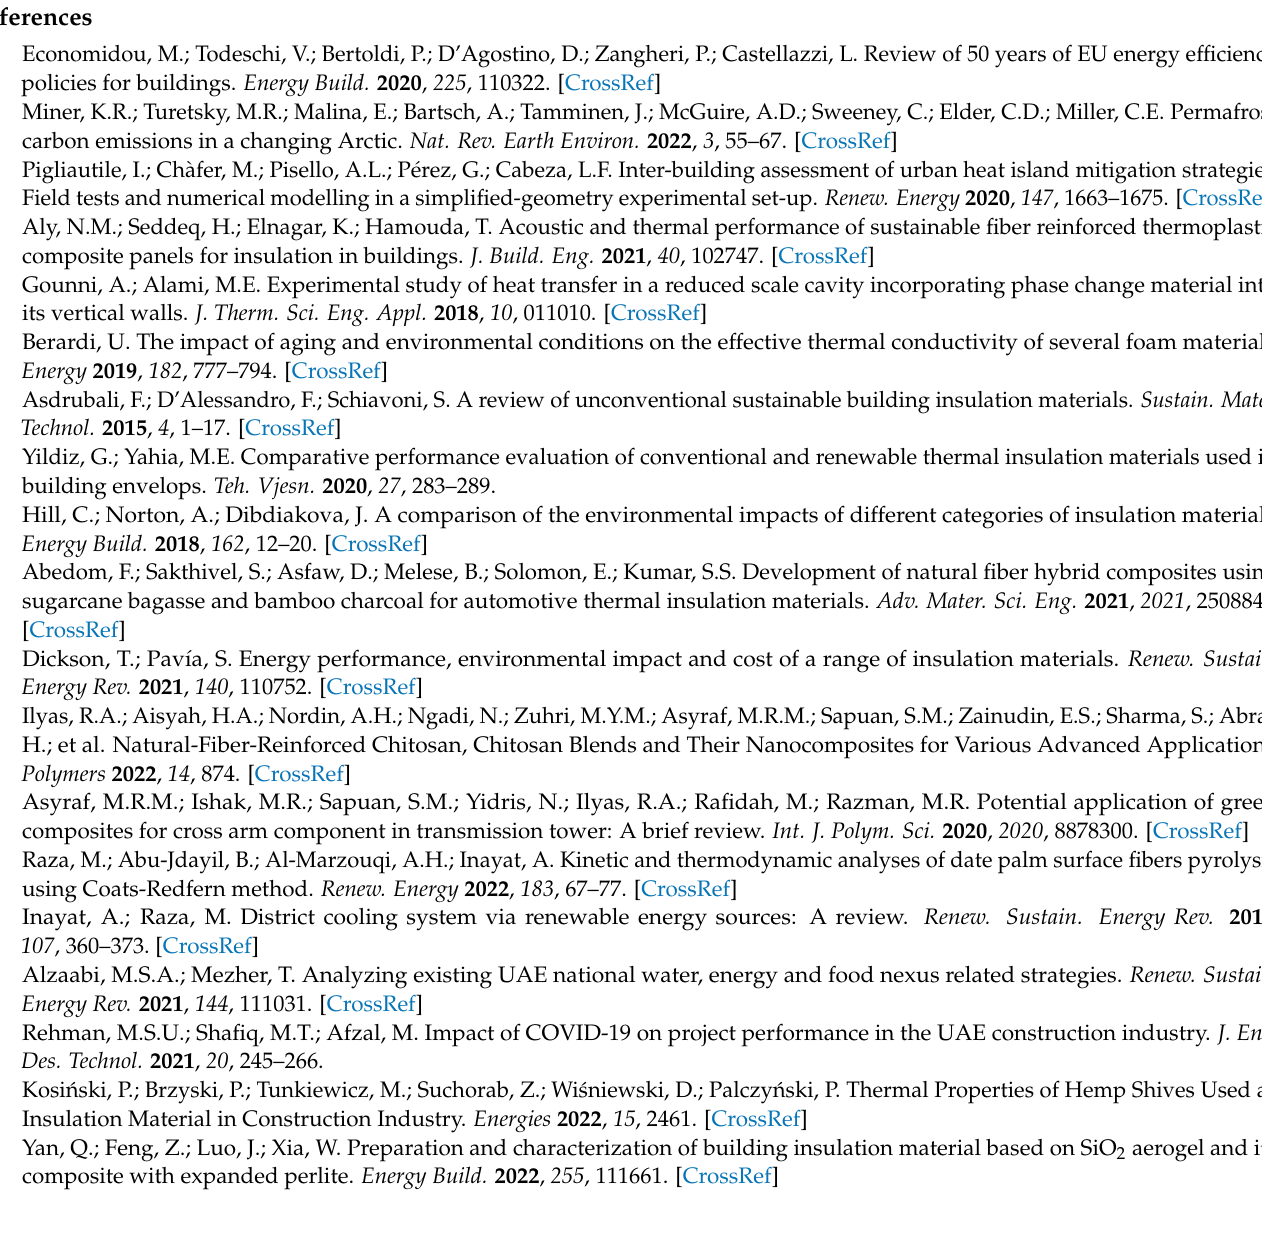
18 of 21 Figure 17. Stress–strain graphs of insulation composites. Table 7. Mechanical properties of insulation composites. Sample